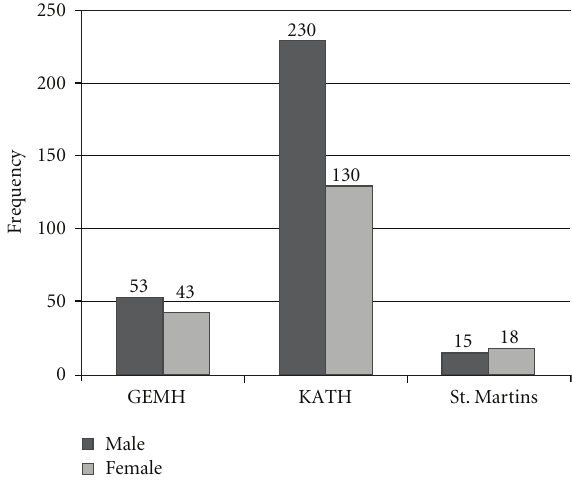
Figure 1: Gender distribution in the various treatment cen- ters. GEMH: Global Evangelical Mission Hospital. KATH: Komfo Anokye Teaching Hospital. St. Martins: St. Martins Catholic Hospital.